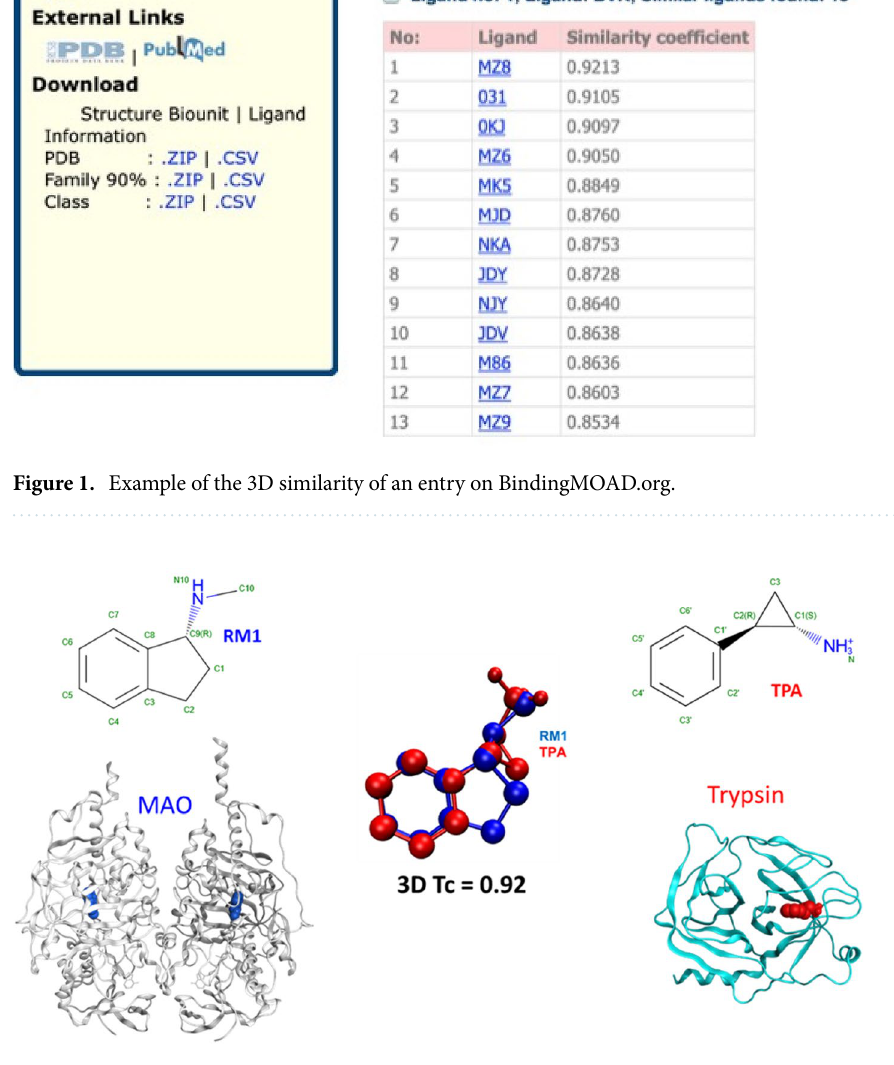
Figure 2. TPA has little 2D similarity to RM1, and its binding site in trypsin has no similarity to the binding site of MAO. However, their 3D similarity shows the connection of TPA as an inhibitor of